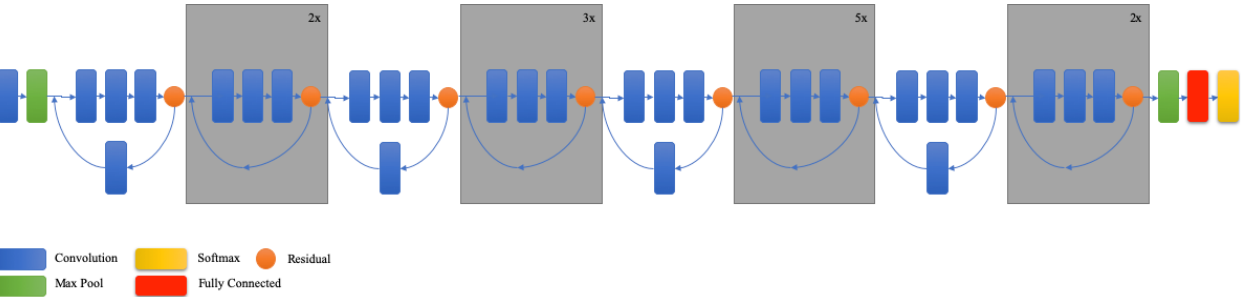
Figure 4. Schematic diagram of ResNet model (compressed view) [31].